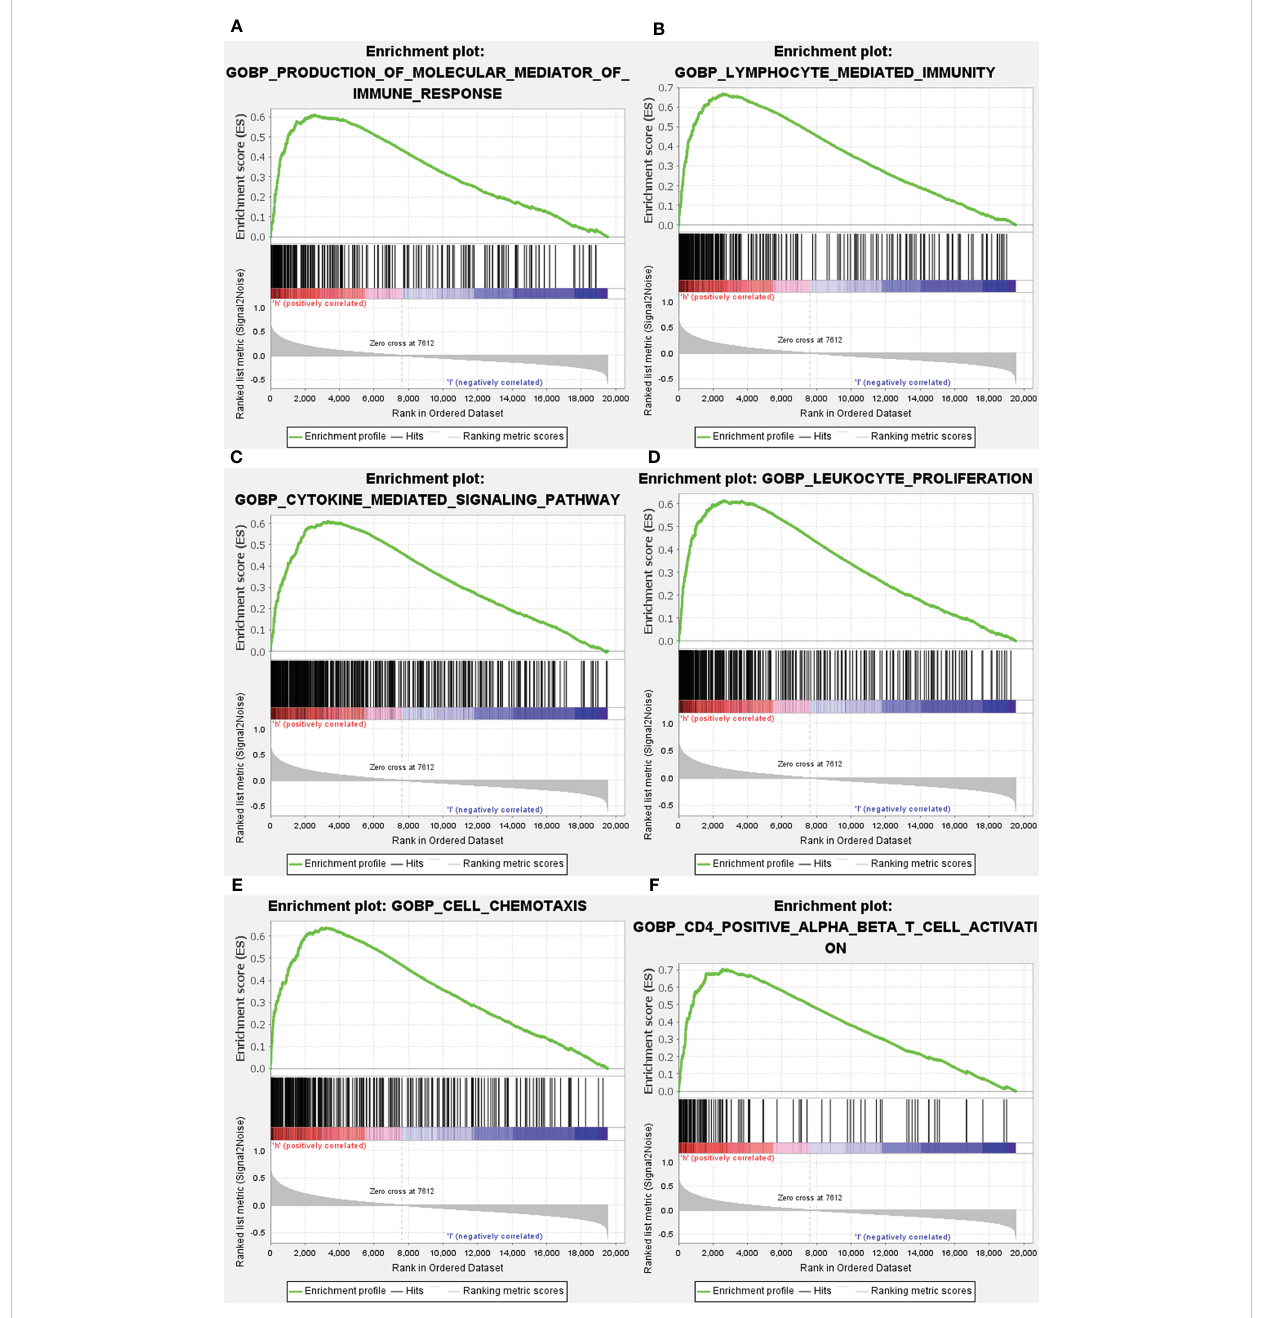
FIGURE 7 Enrichment plots from gene set enrichment analysis (GSEA). GSEA results showing differential enrichment of genes in GO with high GRN expression: production of molecular mediator of immune response (A) , lymphocyte mediated immunity (B) , cytokine mediated signaling pathway (C) , leukocyte proliferation (D) , cell chemotaxis (E) and CD4 positive alpha beta T cell activation (F) were showed signi fi cantly differential enrichment based on NES, NOM P value, and FDR